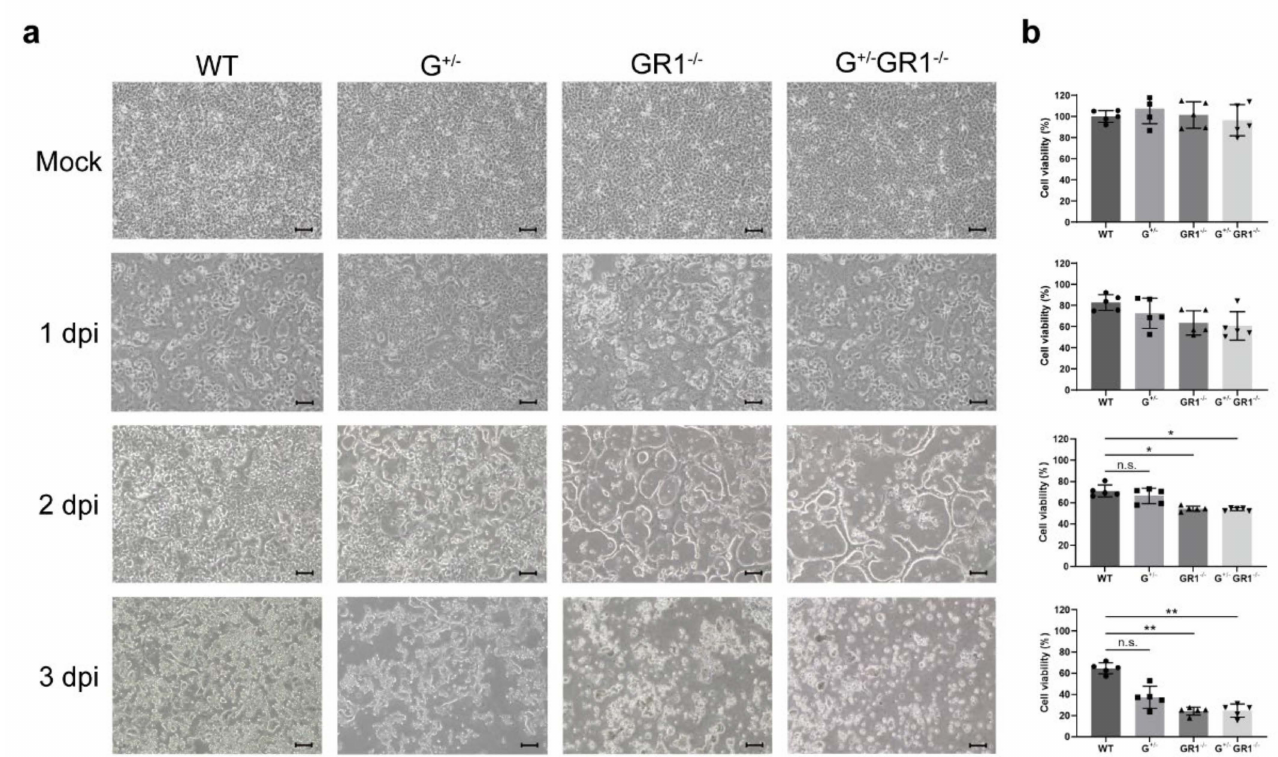
Figure 3. Susceptibility of IFNG - and IFNGR1 -knockout Vero cell lines to HSV-1 infection. ( a ) The cytopathic effects of HSV-1 infection in G +/ − , GR1 − / − , and G +/ − GR1 − / − cell lines in comparison to wild-type cells. Cytopathic effects were monitored daily with a light microscope, and photographs of cell monolayers were acquired every 24 h after infection. Representative images are shown from independent triplicates. Scale bars: 10 µ M (applies to all microscopic images). ( b ) Relative viability of G +/ − , GR1 − / − , and G +/ − GR1 − / − cell lines after HSV-1 infection compared with that in wild-type cells. Cell viability was determined by MTT assay. Cell viability in each cell line was normalized to that of uninfected wild-type controls. Results are shown as means ± SD of five independent replicates (applies to all MTT assays, * p < 0.05; ** p < 0.01; n.s., not